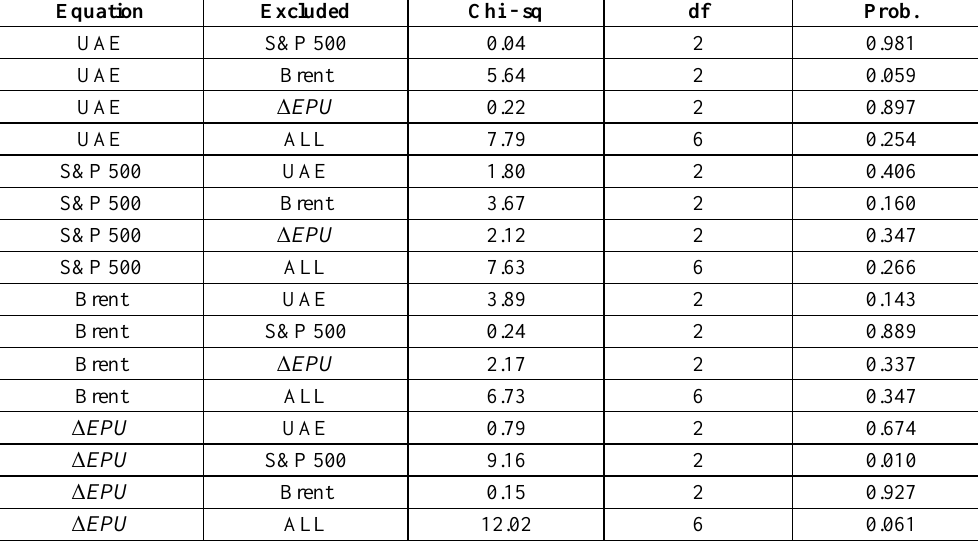
Table 10. Granger Causality Wald